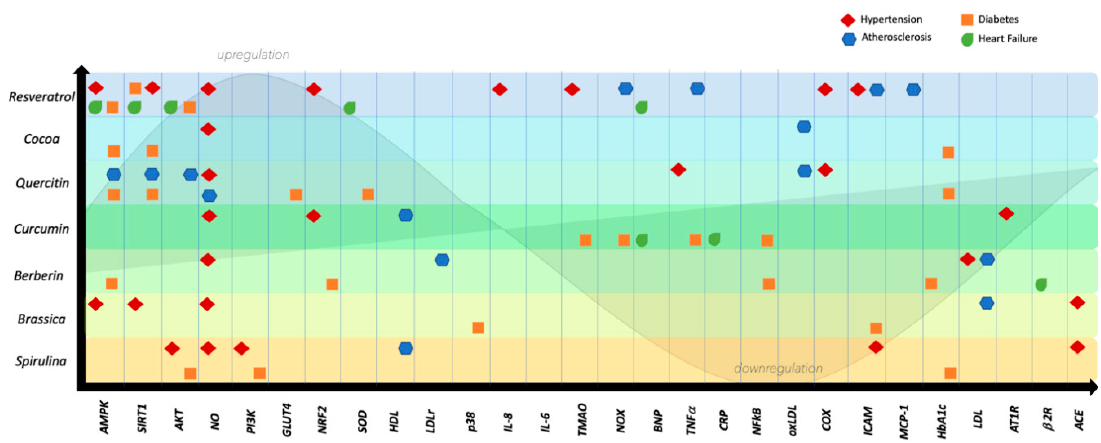
Figure 5. Schematic summary of the molecular effects of nutraceuticals in different CVDs. Funding: This research received no external funding.